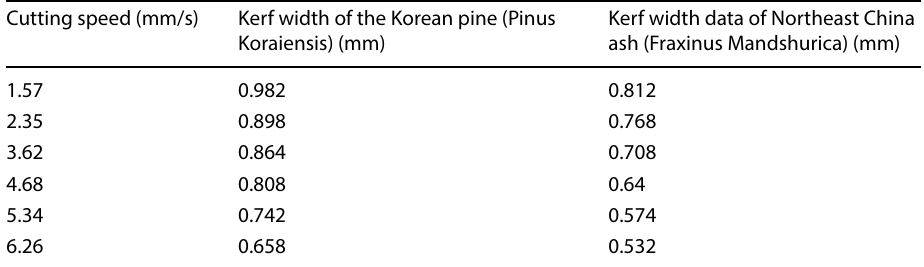
Table 15 Comparative kerf width data of the two wood workpieces under M